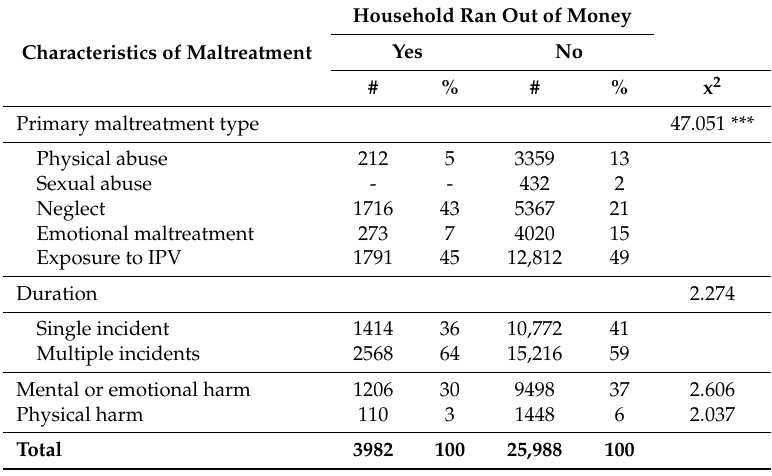
Characteristics of Maltreatment